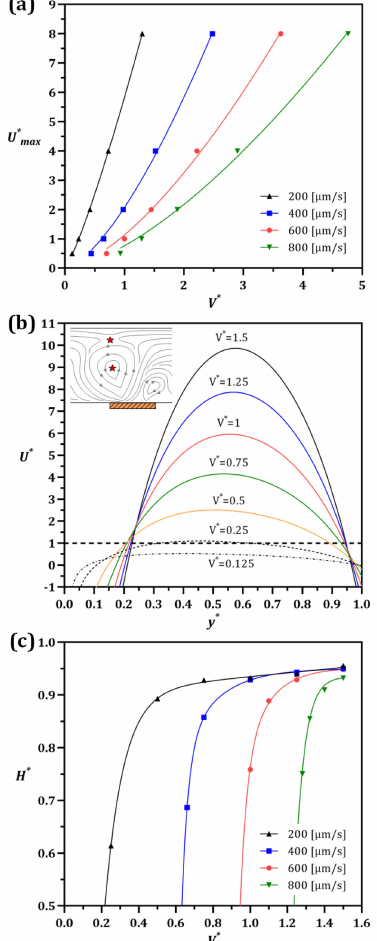
Figure 5. ICP adjustments. ( a ) The nonlinear relationship between U ∗ max and V ∗ estimated and formulated by U ∗ max = aV ∗ n at each lateral velocity. ( b ) The U ∗ calculated along the channel height starting from the left corner of the membrane toward the channel roof at U L = 200 [ µ m/s]. The brown rectangle indicates the membrane’s location. The stagnation locations are highlighted by the red stars in the subset and the dashed line when U ∗ = 1. If the interception happens twice, it means the vortex has already emerged. ( c ) The variation of the dimensionless vortex size ( H ∗ ) by the voltage difference ratio at different U L